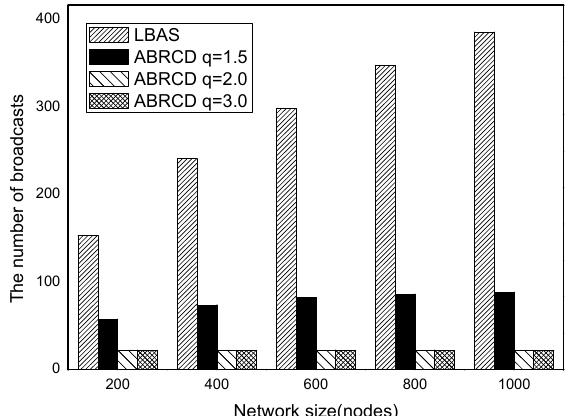
Figure 31. The impact of | T | with fixed network size = 1000 on the number of broadcasts.